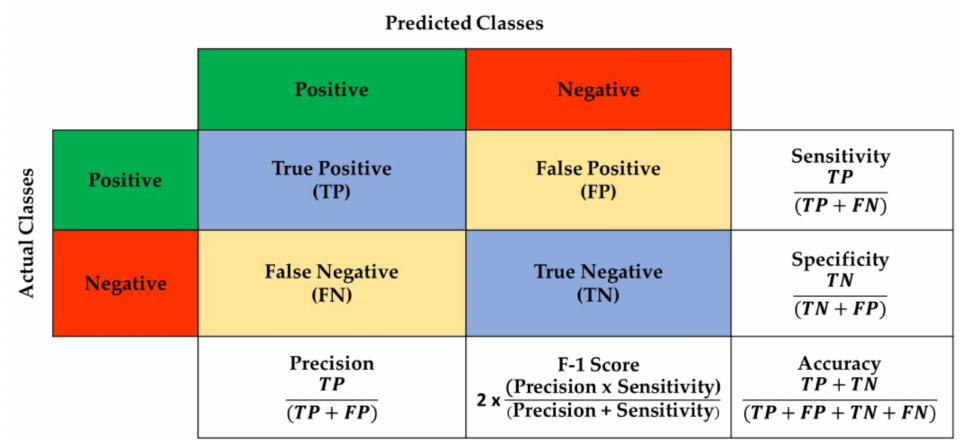
Figure 9. Summary of evaluation metrics employed in this